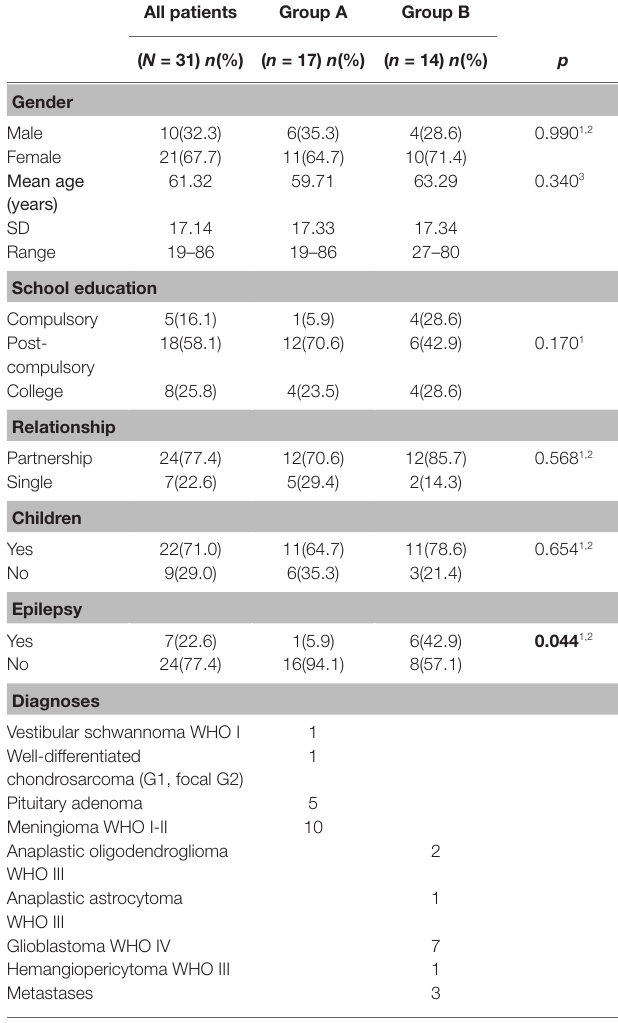
TABLE 1 | Sample characteristics.